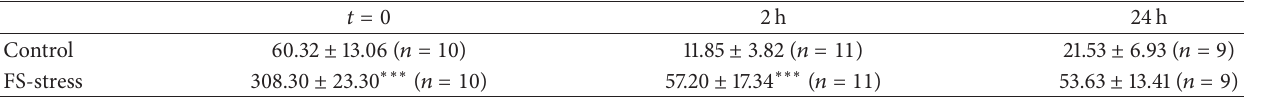
Table 1: Corticosterone serum